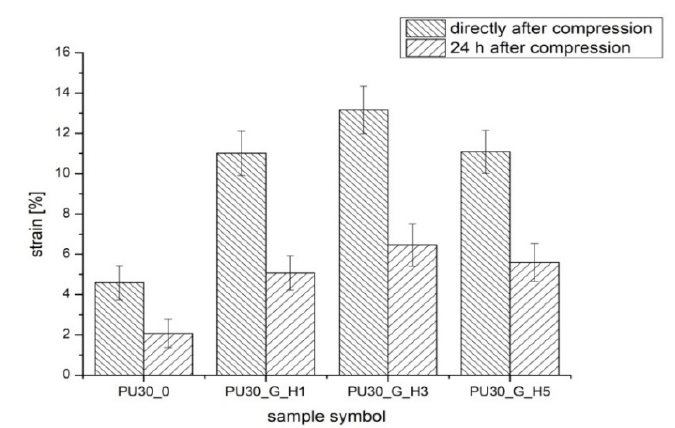
Figure 4. The strain directly after compression and after 24 h of PUR scaffolds.